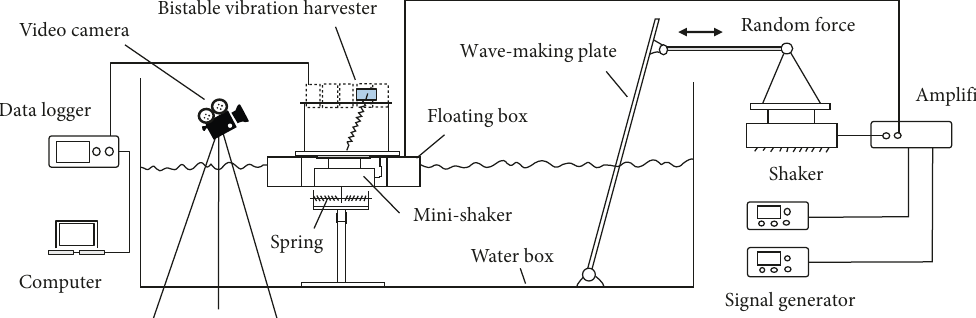
Figure 1: Diagram of experimental settings of bistable vibration energy harvesting system in the wave